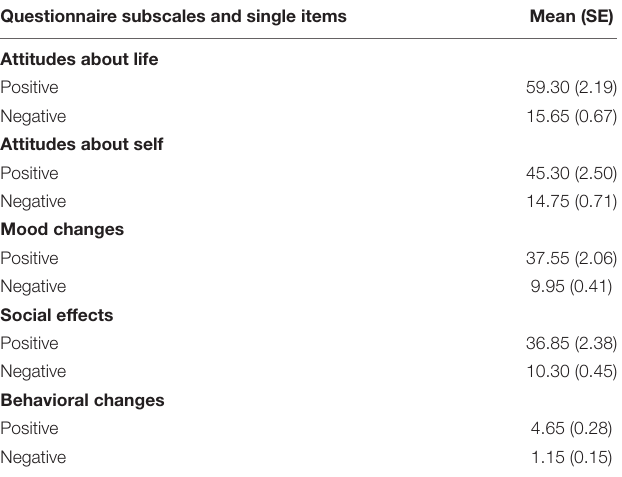
TABLE 2 | Mean (SE) scores on outcome measures of the persisting effects questionnaire. Questionnaire subscales and single items